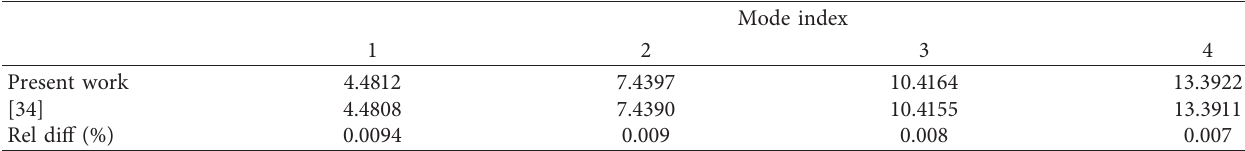
Table 8: The first four eigenvalues for clamped-clamped tapered beams varying in depth with a taper ratio denoted by α : α � 0 . 2 and ) � ( 1 − α ( x / L )) . ( S ( x ) / S 1